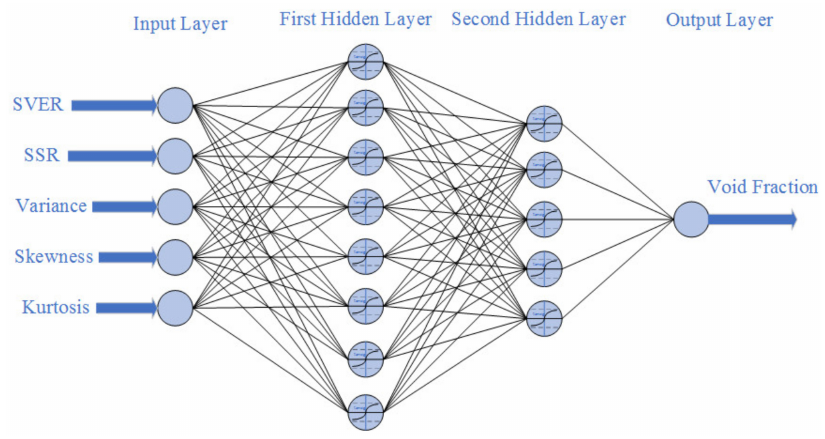
Figure 8. The configuration of the presented network for predicting void fraction.